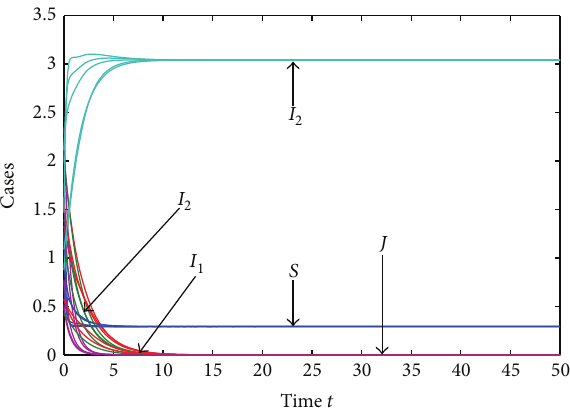
Figure 4: shows that 𝐸 2 is globally asymptotically stable.